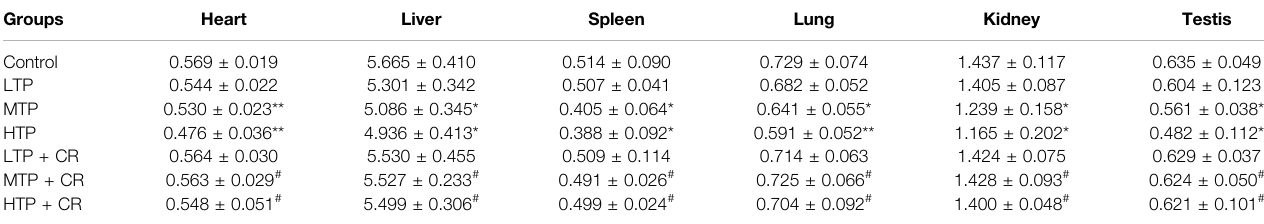
TABLE 2 | Comparison of organ coef fi cients in each group ( (cid:1) x ± S, n = 6). Groups